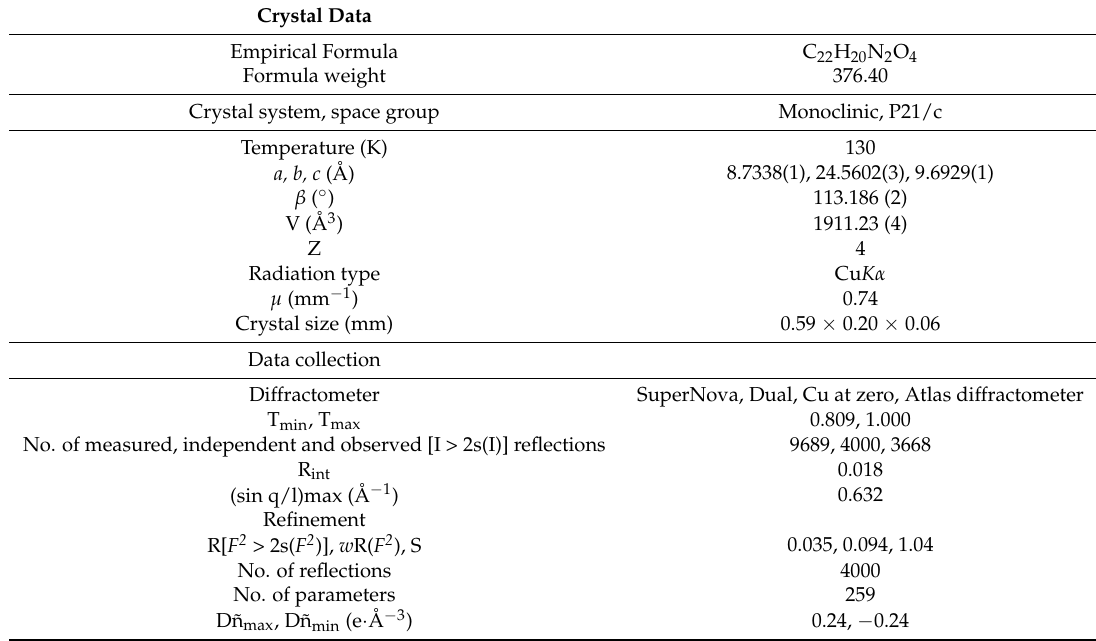
Table 3. Crystallographic data of titled compound ( 1